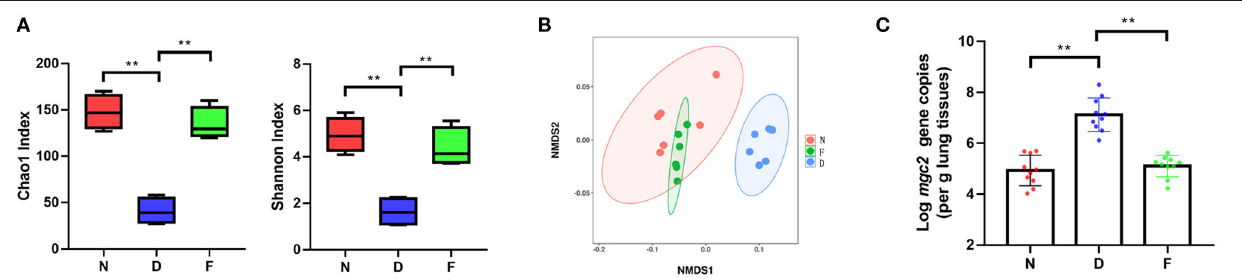
FIGURE 2 | The effects of gut microbiota dysbiosis on MG colonization in lung. (A) Alpha diversity of gut microbiota in each group ( n = 6), fecal samples were collected in the 48 day of age without MG challenge. (B) Non-metric multidimensional scaling (NMDS) of the gut microbiota composition on the operational taxonomic